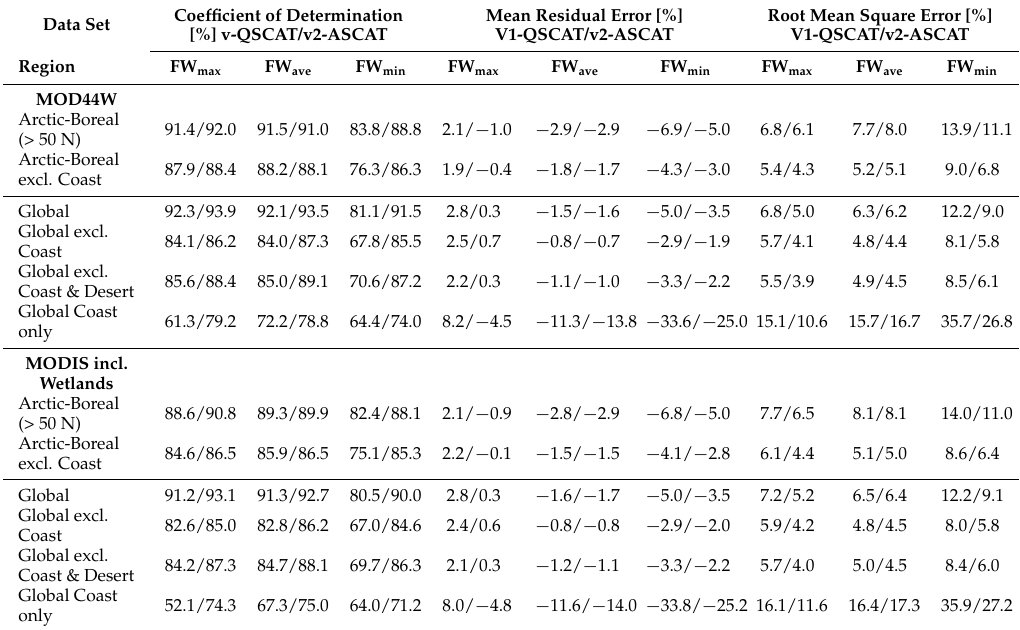
Table 4. Summary statistics from pixel-wise comparisons of mean annual fractional water (FW) generated from v1-QSCAT (2000–2008) and v2-ASCAT (2009–2012) monthly maximum (FW max ), average (FW ave ), and minimum (FW min ) record periods against static FW from the MOD44W and MODIS including wetlands products. Relationships are significant at a minimum 0.01 probability